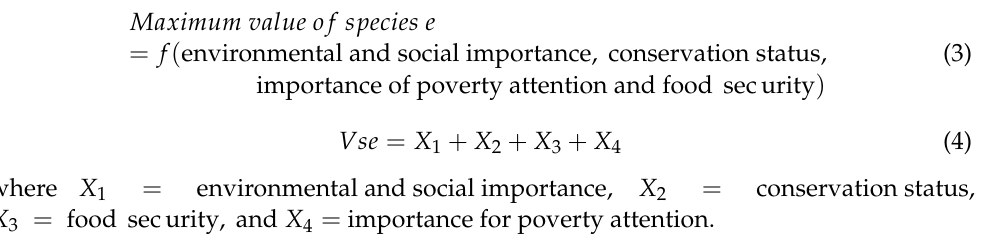
Table 4. Most important final Vse values for multi-use tree species.